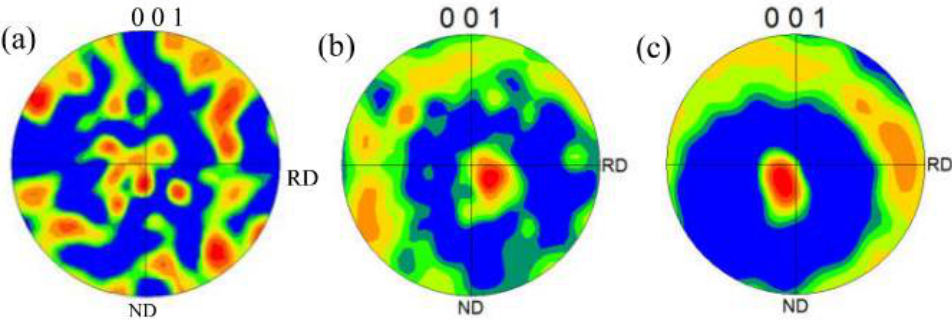
Figure 14. (001) Pole figures: ( a ) unbent; ( b ) bent lower end plate; ( c ) bent upper end plate.